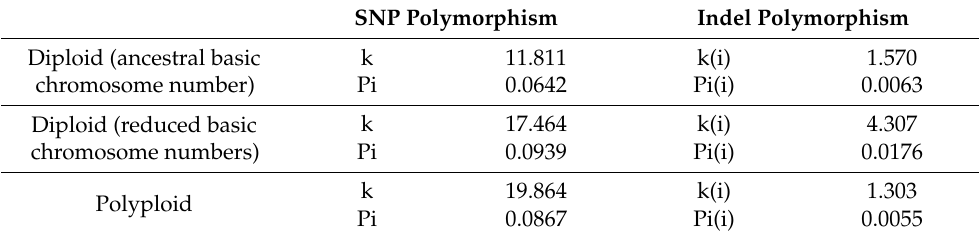
Table 1. ITS1 sequence diversity based upon 85 sequences of Trifolium